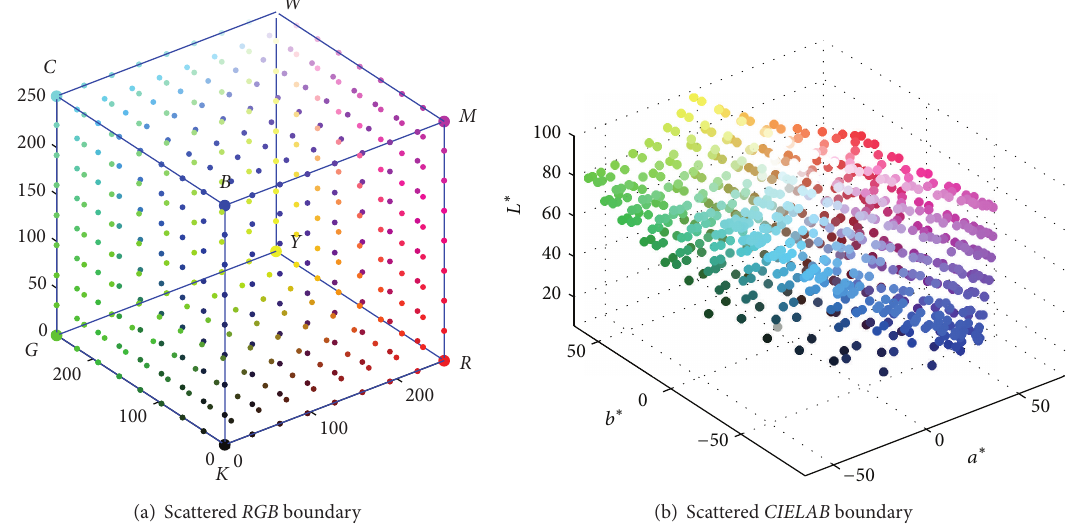
Figure 2: Scattered samples in colorant and colorimetric